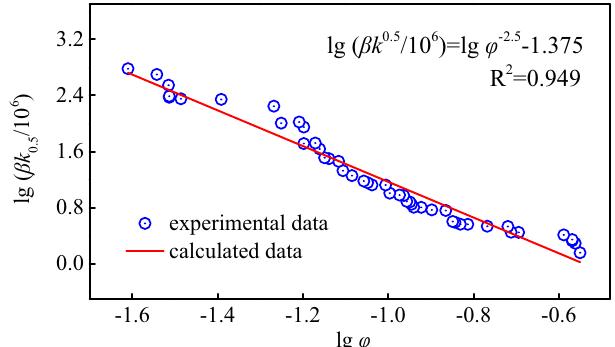
Figure 9. Non-Darcian coefficient of each sample through the fitting curve of the pressure gradient versus the flow